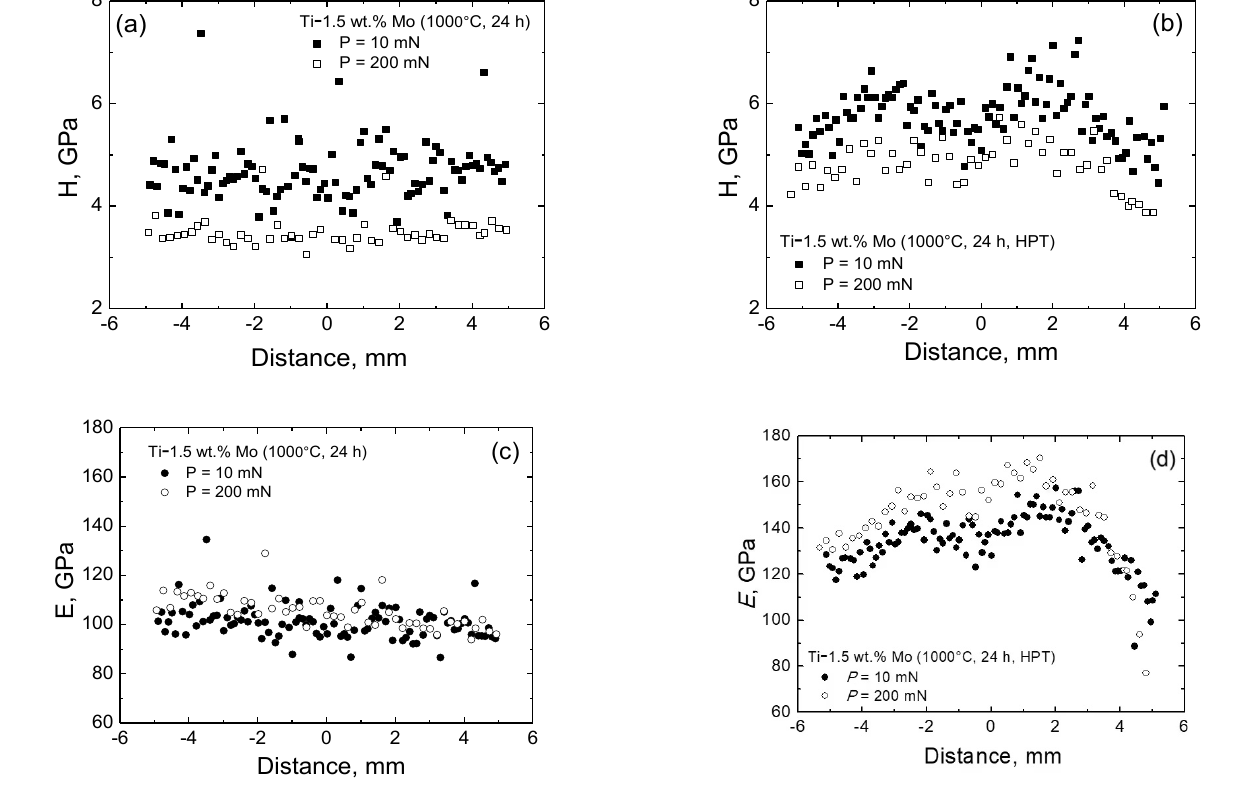
Figure 8. The dependences of nano- and microhardness H ( a , b ), as well as Young’s modulus E ( c , d ) on the distance across the sample (0 corresponds to the disc center) for the Ti – 1.5 wt.% Mo alloy before and after HPT.